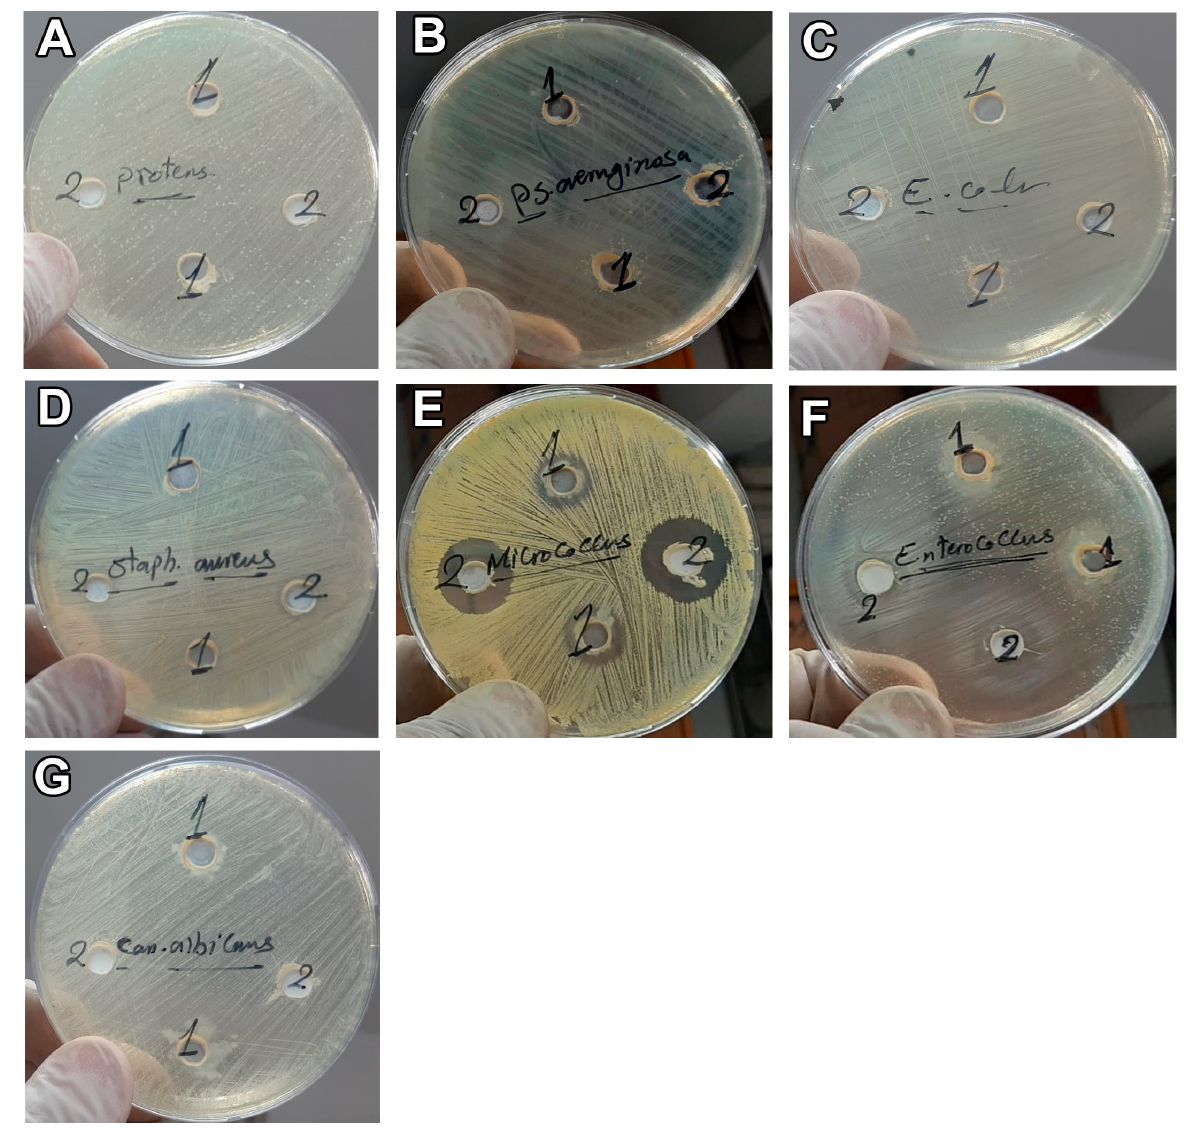
Figure 2. Inhibition zone assay shows the effect of CM on Gram-negative bacteria: P. mirabilis ( A ), P. aeruginosa ( B ) and E. coli ( C ), Gram-positive bacteria: S. aureus ( D ), M. luteus ( E ), and E. feacalis ( F ), and fungi, C. albicans ( G ).